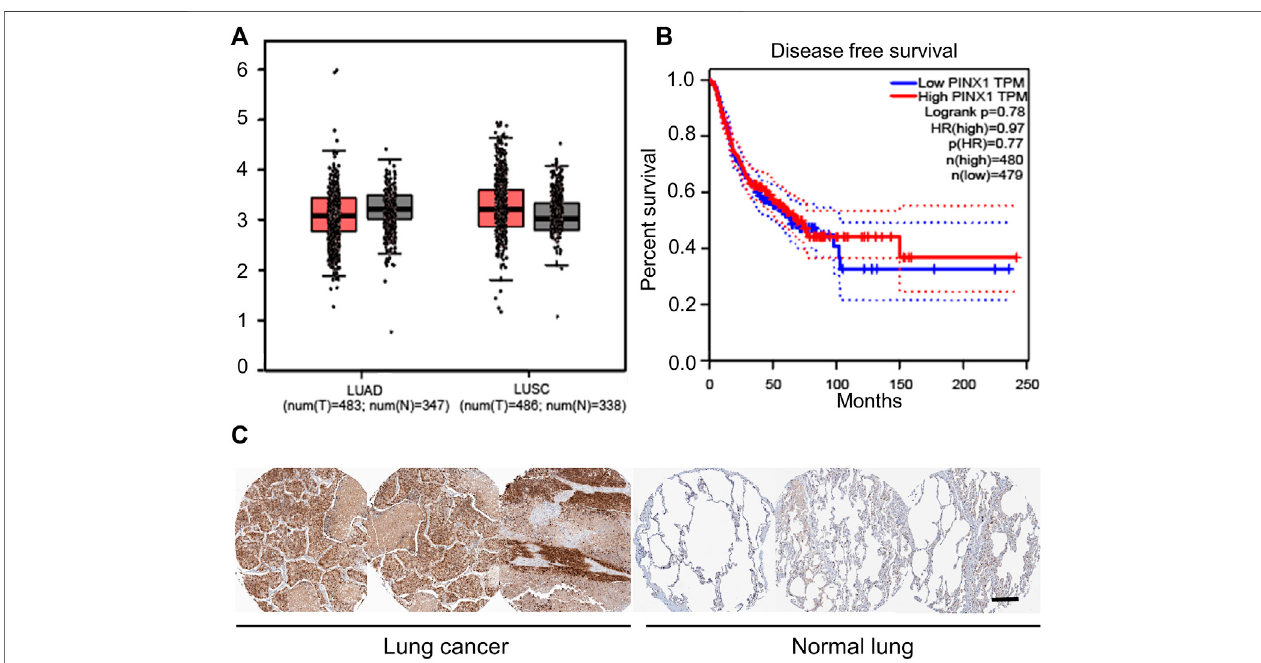
FIGURE 2 | PinX1 may be a key target for chemoprevention of lung cancer. (A) PinX1 expression in LUSC and LUAD by the Gene Expression Pro fi ling Interactive Analysis (GEPIA). (B) Relation between pinX1 expression and survival time. (C) Representative pinX1 expression in the lung and lung cancer from the Human Protein Atlas (HPA) database. Scale bar = 200 μ